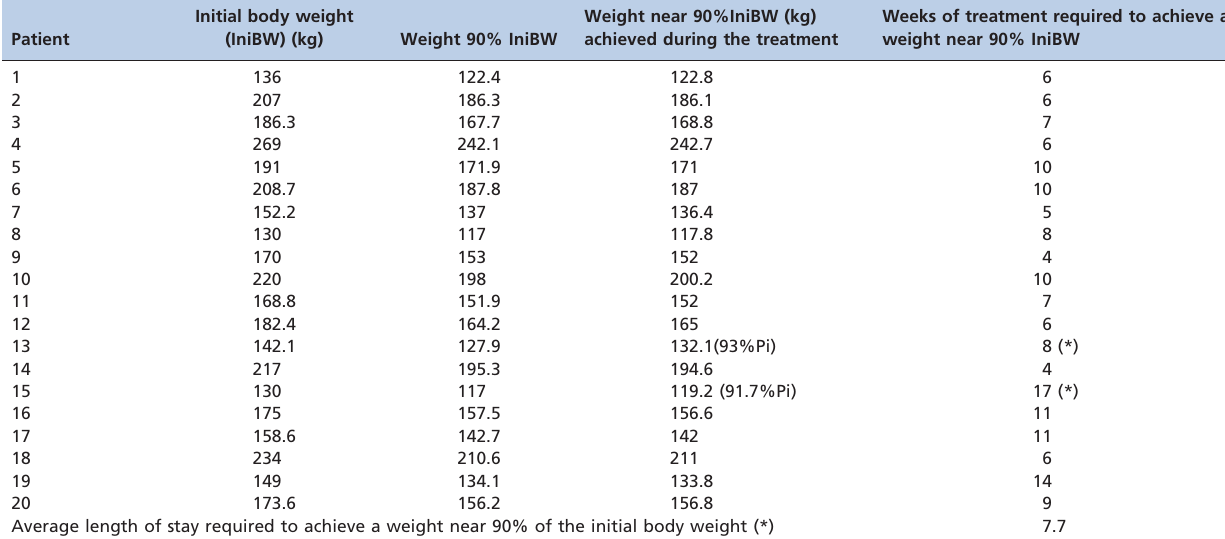
Table 2 - Length of stay necessary to achieve an approximately 10% loss of initial body